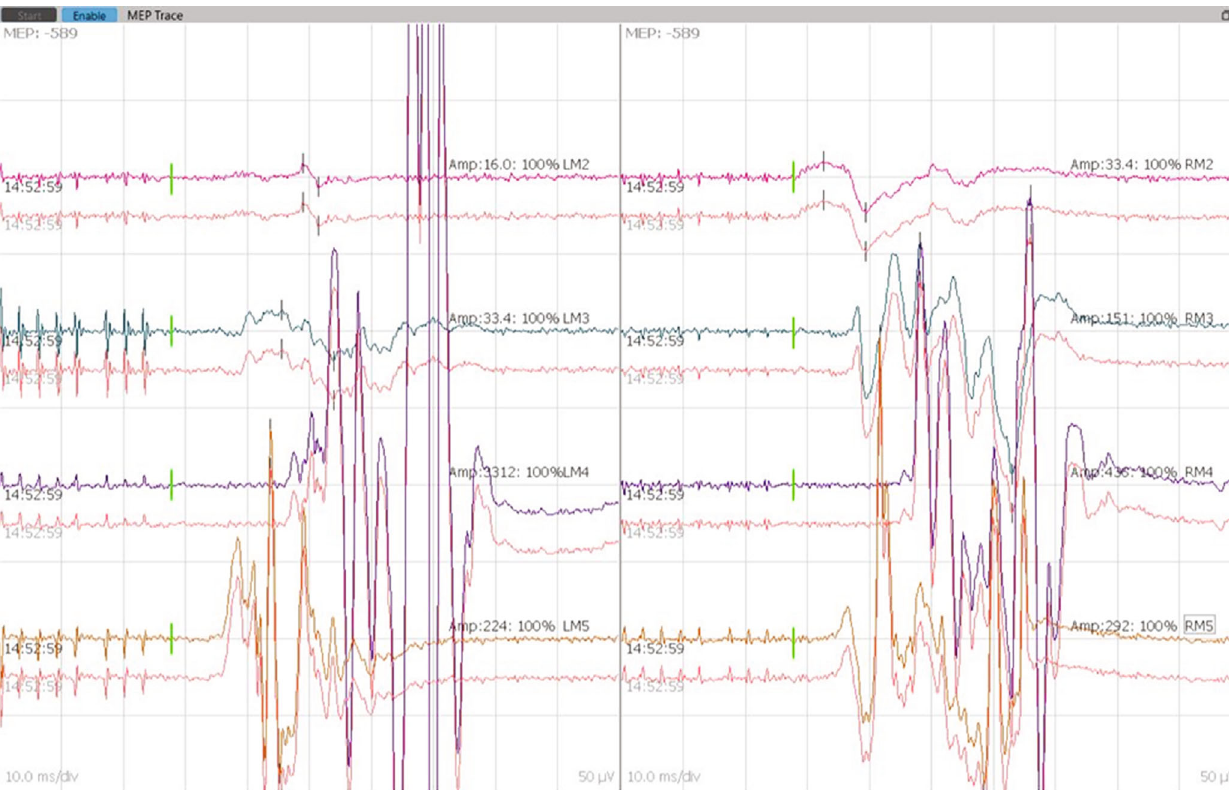
Figure 1: Baseline MEP response of a patient from microendoscopic discectomy of the L4/L5 procedure. LM2 and RM2: bilateral vastus lateralis. LM3 and RM3: bilateral tibialis anterior. LM4 and RM4: bilateral abductor hallucis. LM5 and RM5: bilateral medial